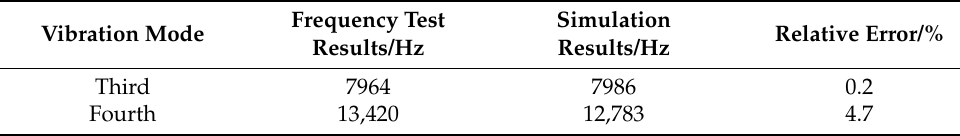
Table 4. Comparison of static frequency simulation and test results.